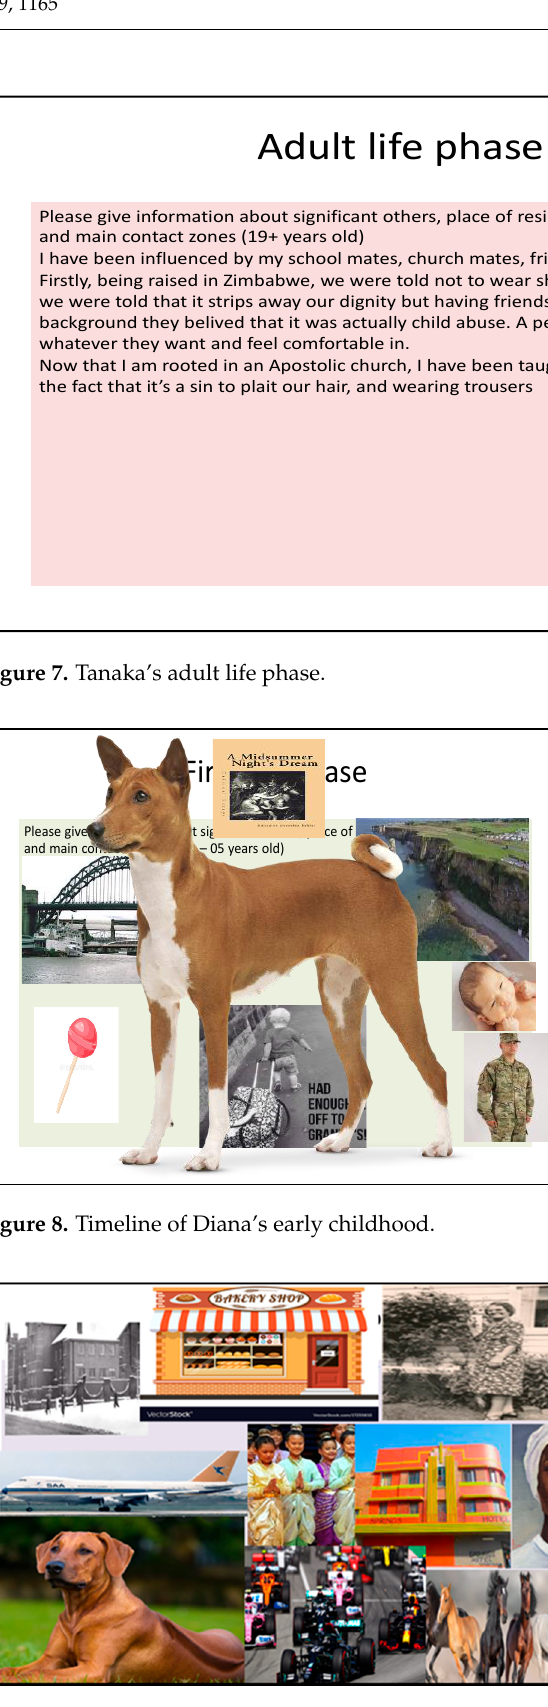
Figure 10. Diana’s adolescent phase.